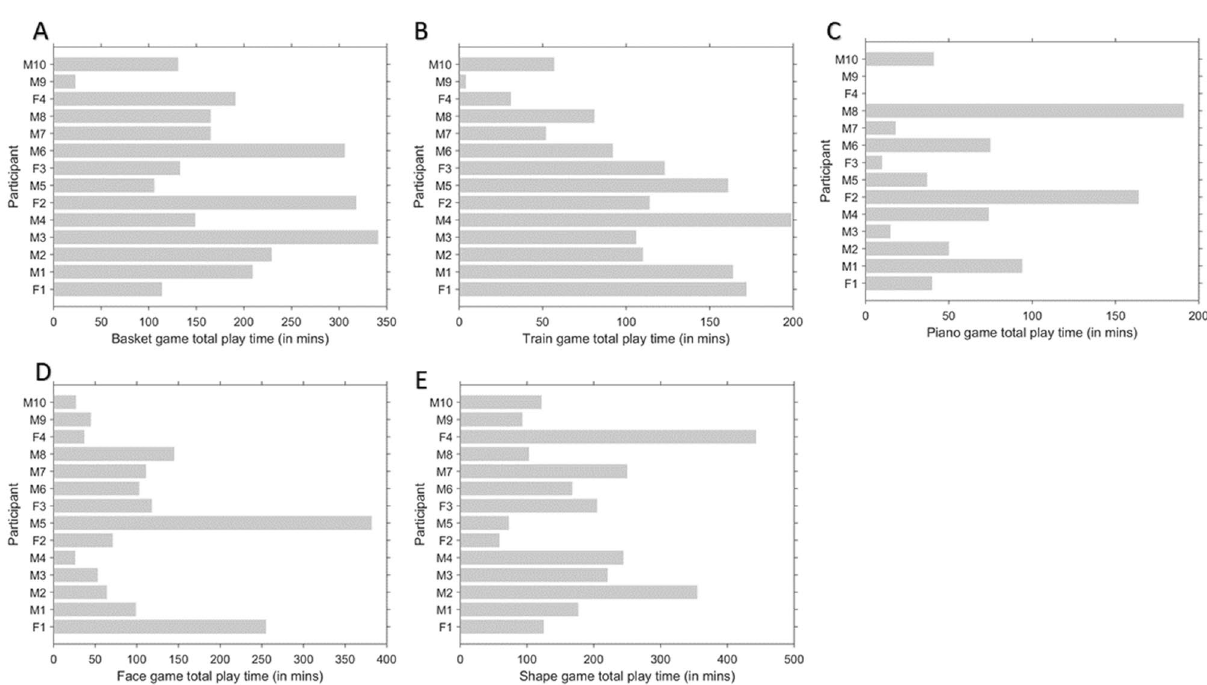
Figure 6. Total time spent on playing each game by the participants. Fx represents female participant numbered x and Mx represents male participant numbered x. Total time for which each participant played (in minutes) ( A ) Basket game (mean = 184.28, SD = 89.63), ( B ) Train game (mean = 104.71, SD = 56.77), ( C ) Piano game (mean = 57.78, SD = 58.41), ( D ) Face game (mean = 109.71, SD = 98.78), ( E ) Shape game (mean = 188.42, SD =